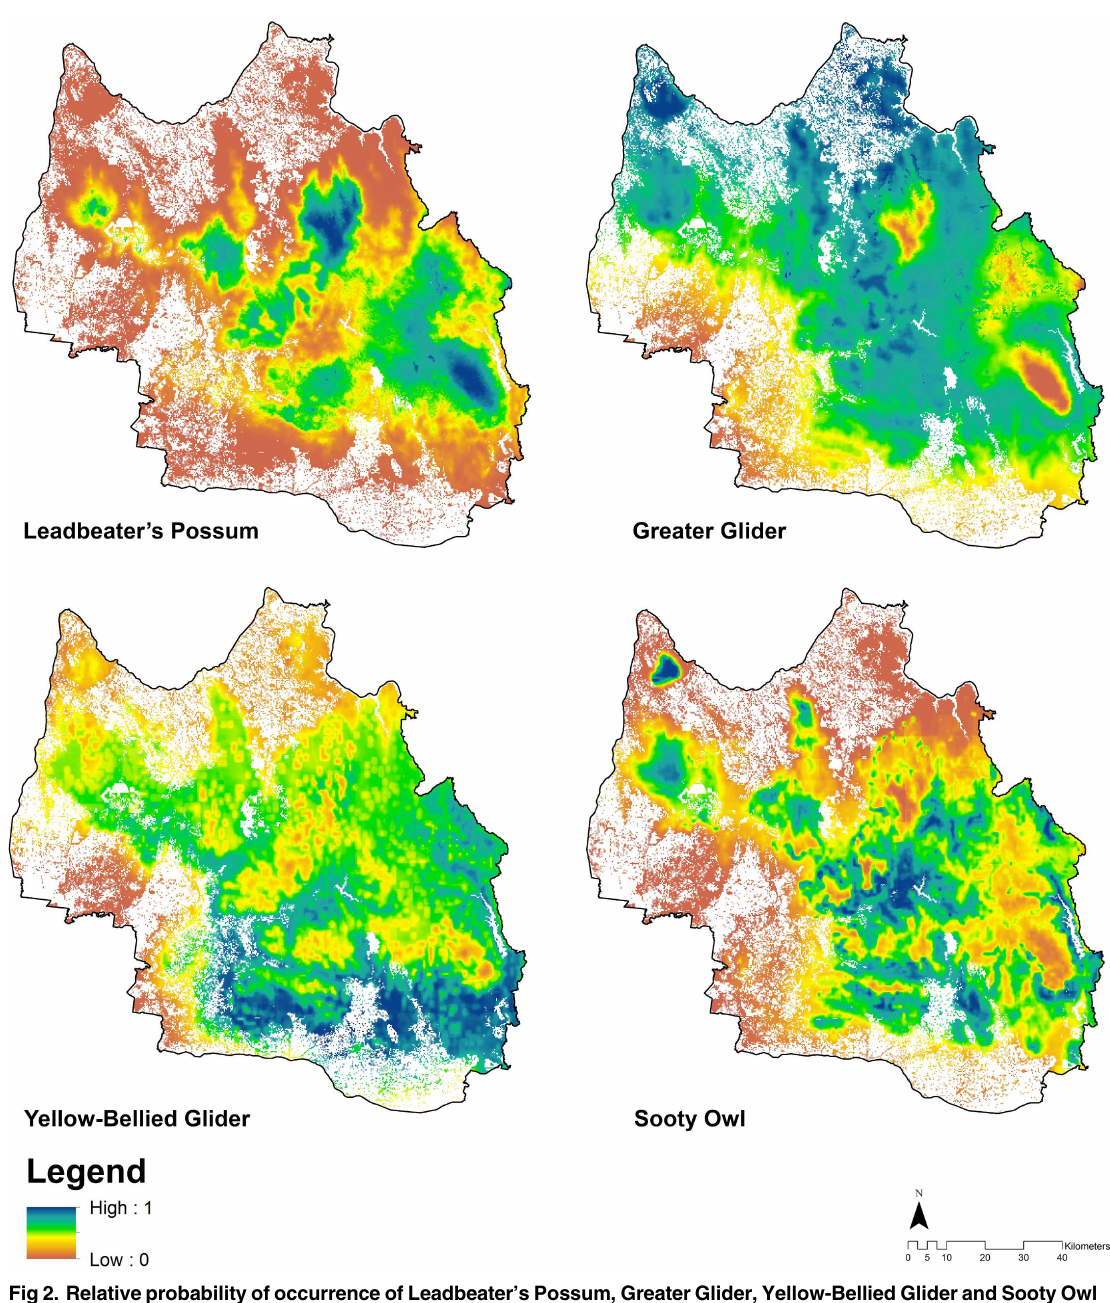
Fig 2. Relative probability of occurrence of Leadbeater’s Possum, GreaterGlider, Yellow-Bellied Glider and Sooty Owl in the Central Highlands of Victoria, ranked as values (0–1).